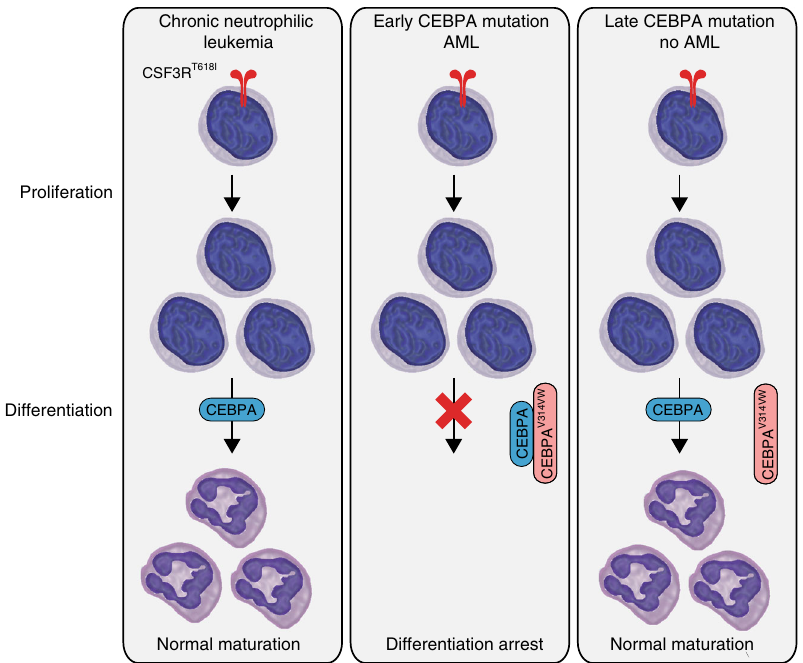
Fig. 8 CEBPA mutations initiate AML through disruption of myeloid lineage enhancers. During normal myeloid differentiation, GCSF/CSF3R signaling drives both differentiation and proliferation of myeloid precursors. The differentiative program downstream of GCSF/CSF3R signaling is dependent on CEBPA acting at myeloid lineage enhancers. Mutant CEBPA blocks activation of these enhancers preventing transcription of differentiation-associated genes. When CSF3R mutations are introduced early, they activate transcription using the native enhancer repertoire initiating differentiation. Importantly this differentiation is insensitive to subsequent introduction of mutant